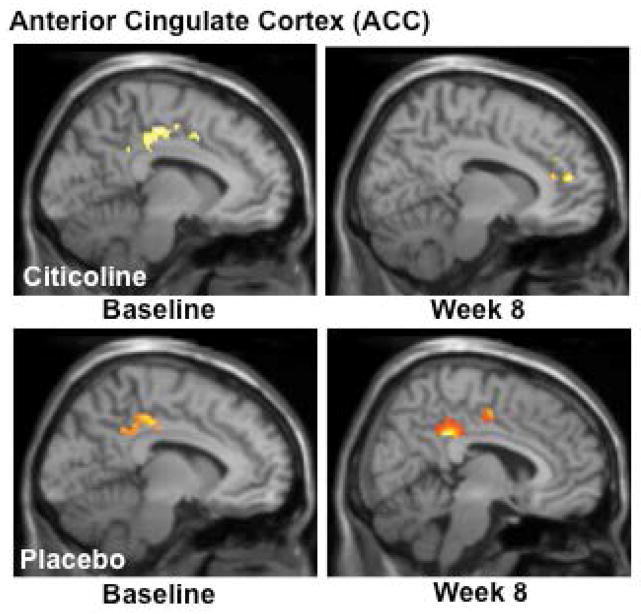
fMRI Analysis of the Stroop Color Word Task: Interference – Color NamingActivation during Stroop (Interference condition minus the Color Naming condition) highlighted a shift from posterior/midcingulate to genual cingulate activation and a corresponding reduction in total voxel cluster size in the citicoline-treated group. The placebo-treated group demonstrated a pattern of posterior ACC activation at baseline which persisted at the 8 week scan, with only minor midcingulate activation and an increase in total voxel cluster size. (k=total cluster size with p < 0.01(uncorrected) and a threshold of ≥ 10 voxels).